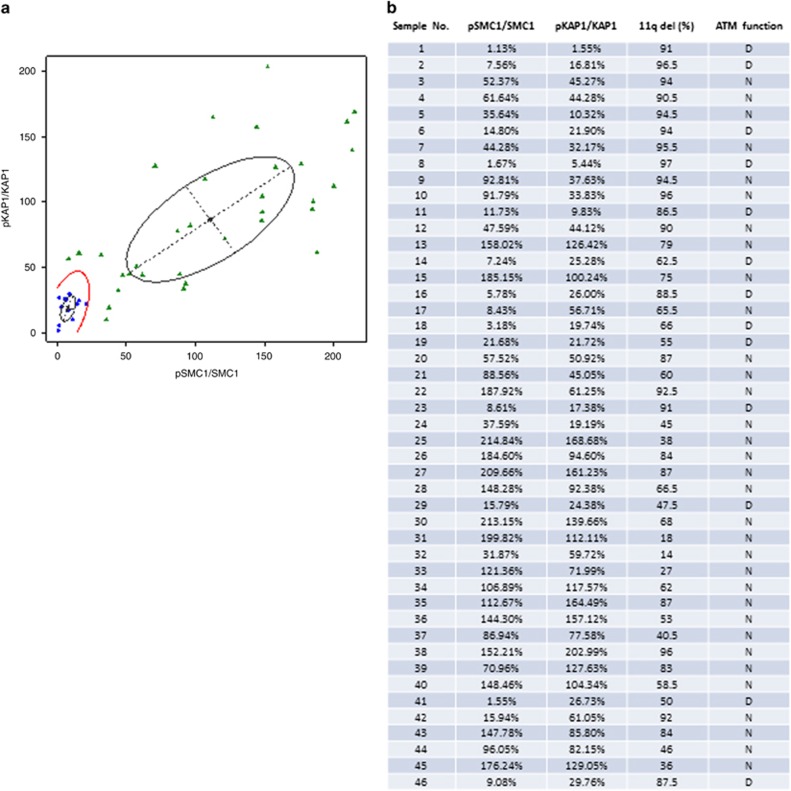
ATM function in 46 11q deletion CLL samples. (a) The normal mixture density and boundary for clusters estimated based for phosphorylation SMC1 and KAP1 relative the Pool. (b) Analysis of pSMC1/SMC1 and pKAP1/KAP1 ratios of the 46 CLL samples. Quantitation of pSMC1/SMC1 and pKAP1/KAP1 was carried out by comparing the levels in these 46 samples against the levels of those in the Pool (set as 100%) statistical formula. D, deficient; N, normal.